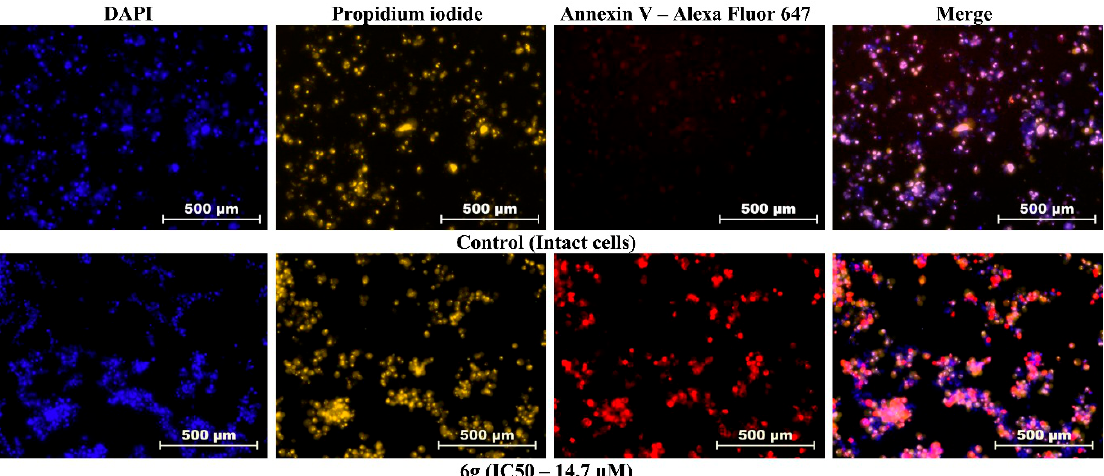
Figure 4. Multiplex analysis of early apoptosis markers in M-Hela cells treated with the test substance 6g at an IC 50 concentration of 14.7 µM as well as M-Hela cells untreated with the test substance (control). The median fluorescence intensity (MFI) was measured using the Luminex ® system. The graph shows the mean and standard deviation values for the wells in triplicate.